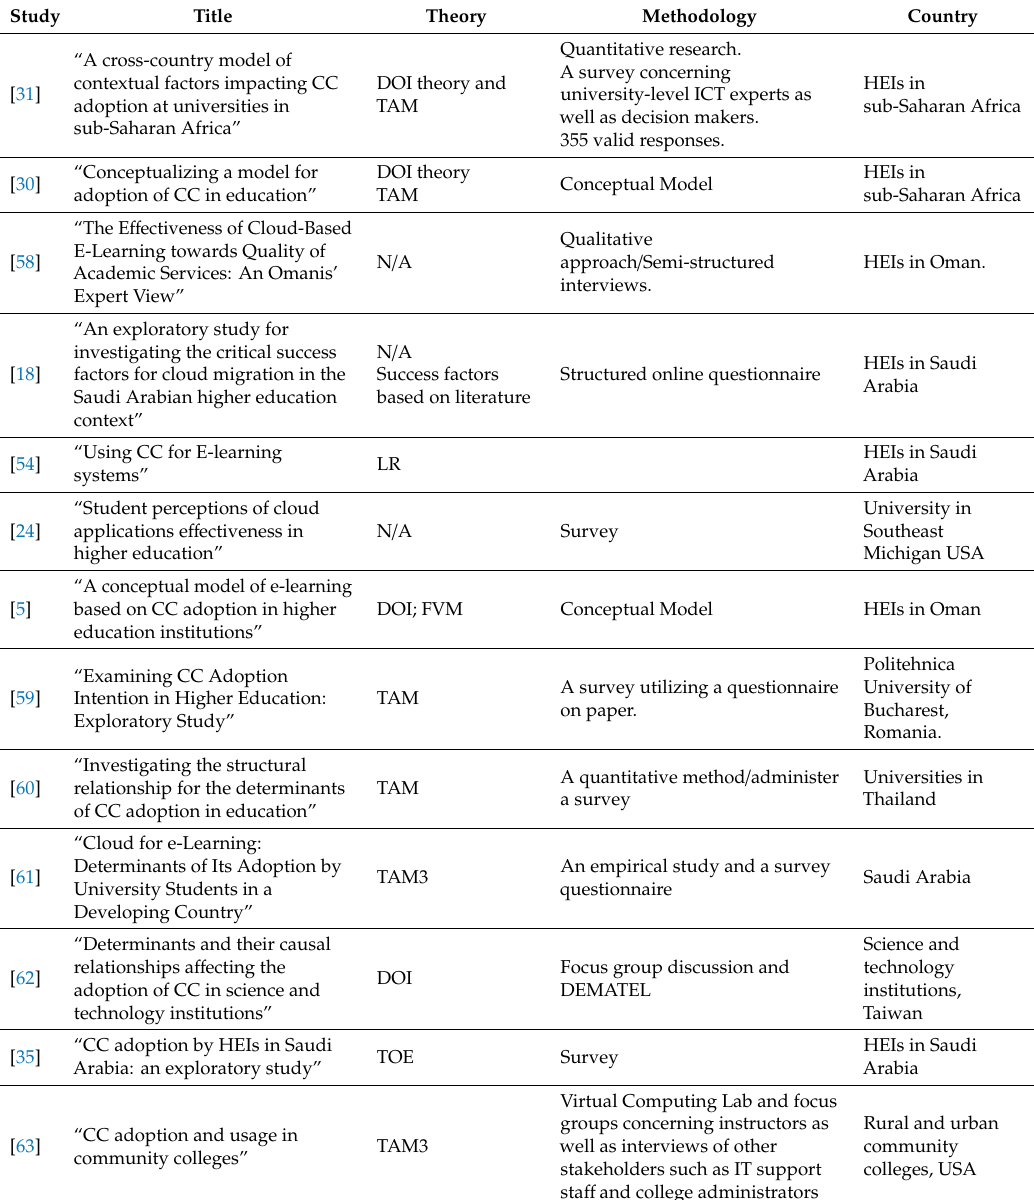
Table 1. The adoption of CC in HEIs: a summary of prior research